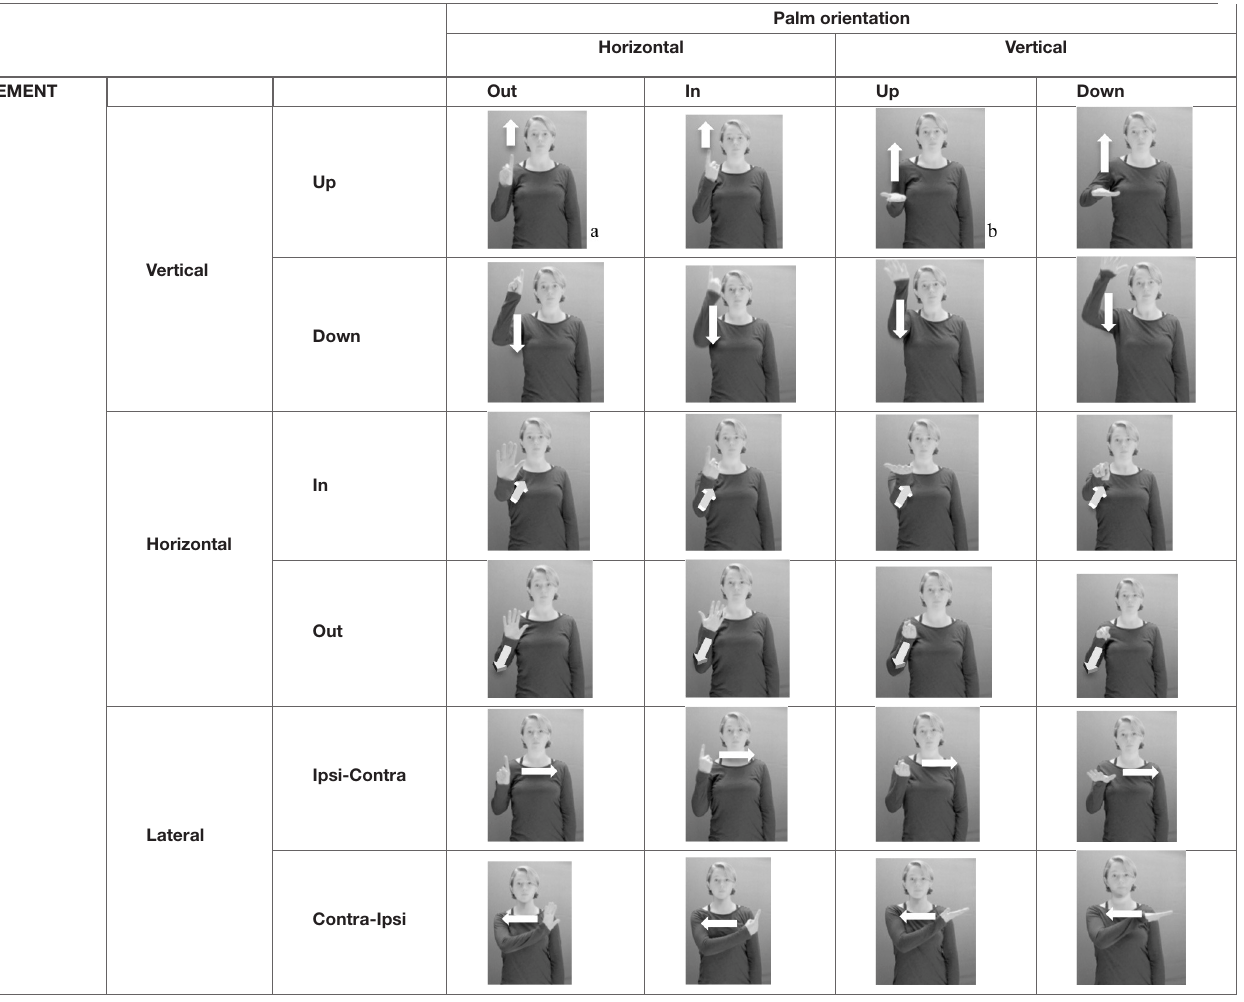
TABLE 2 | Gesture stimulus types by palm orientation and direction of